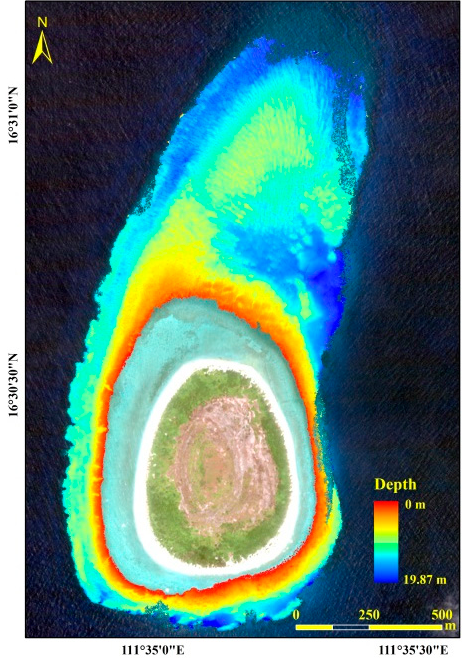
Figure 8. Bathymetric map of the whole sea area.